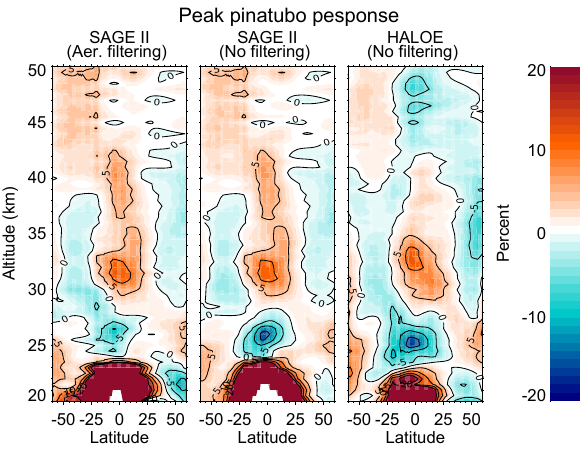
Figure 4. Peak of the volcanic term near the eruption of Mt. Pinatubo as a percentage of the local mean for both SAGE II and HALOE under different regressions. Results for SAGE II are shown both with and without the Wang et al. (2002) filtering criteria. Re- sults for HALOE are shown without any aerosol filtering, though results with filtering are